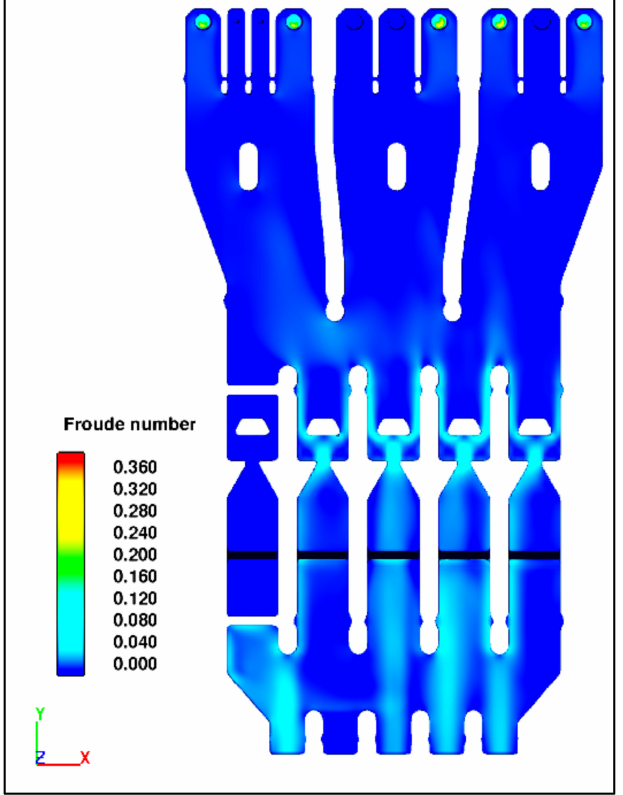
Figure 16. Froude number contours at the basin for scenario V—3D